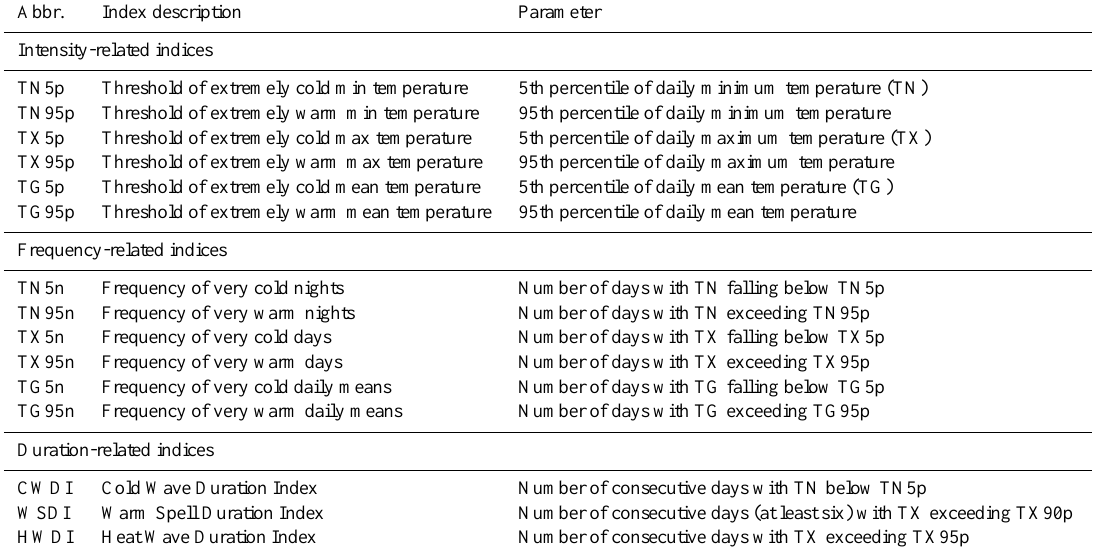
Table 2. Indices of temperature